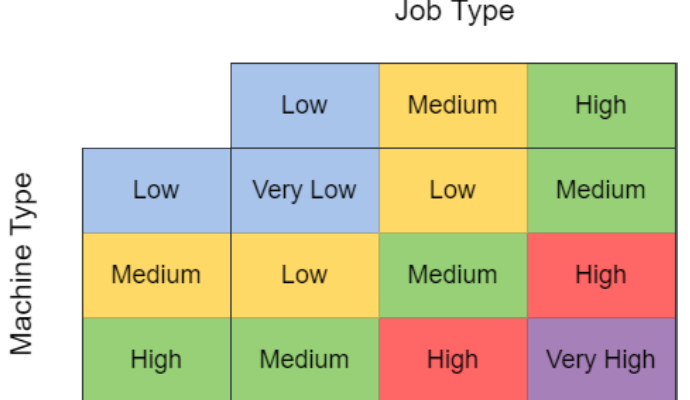
Figure 5. A representation of fuzzy rules used to determine the processing times in the fuzzy